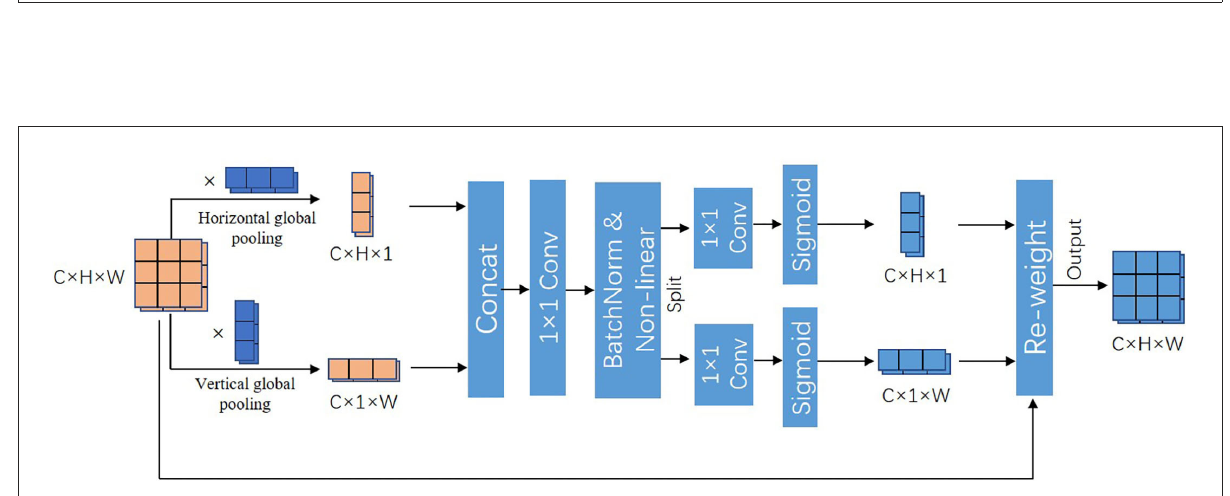
FIGURE8 Coordinate